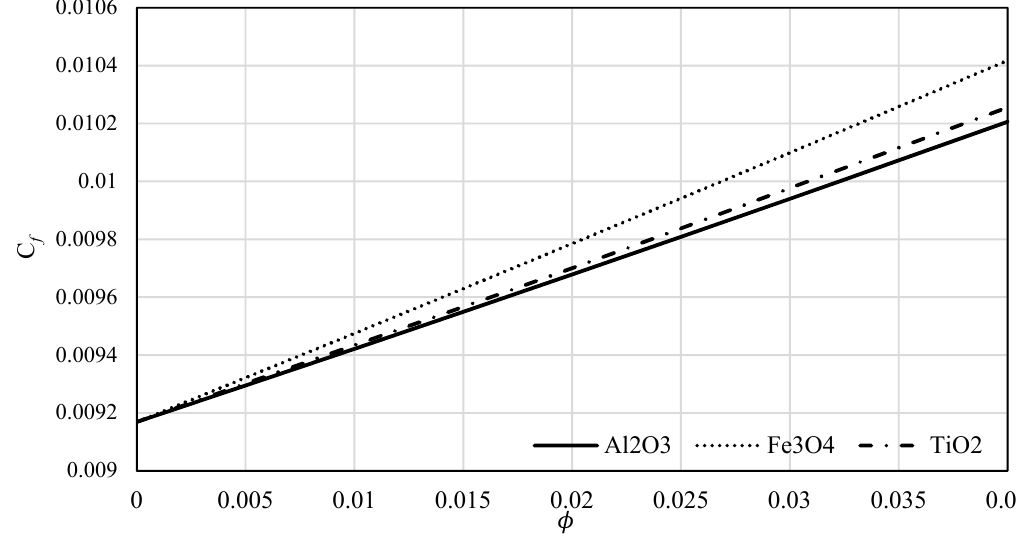
Figure 12. The skin friction C f versus φ for all three nanofluids.